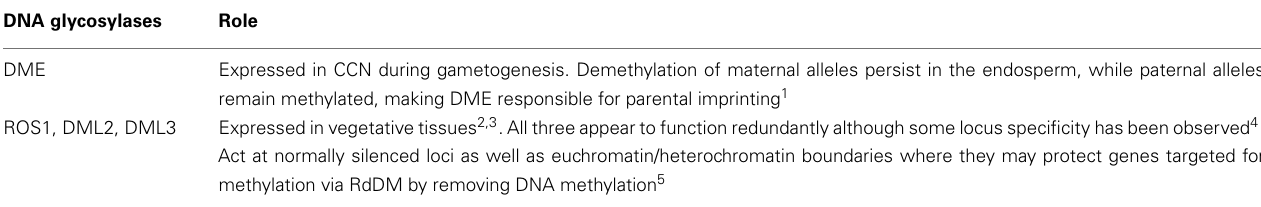
Table 2 |Active DNA demethylation in